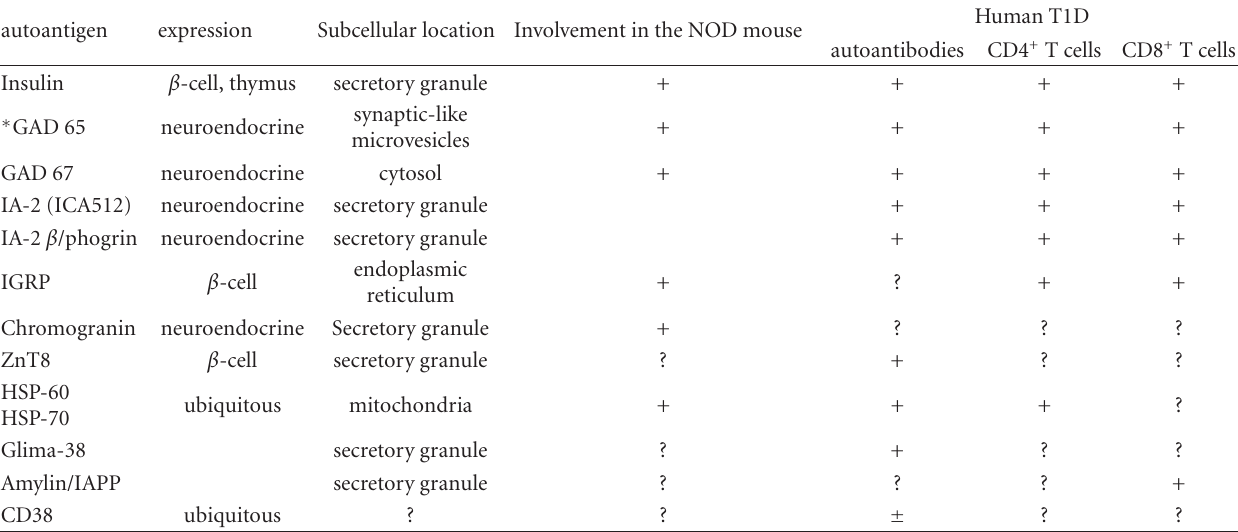
Table 1: Autoantigens defined as recognized by T cells in human T1D. Listing has been limited to autoantigens for which evidence of recognition has been obtained in the human or, if only in the mouse, data are expected in the